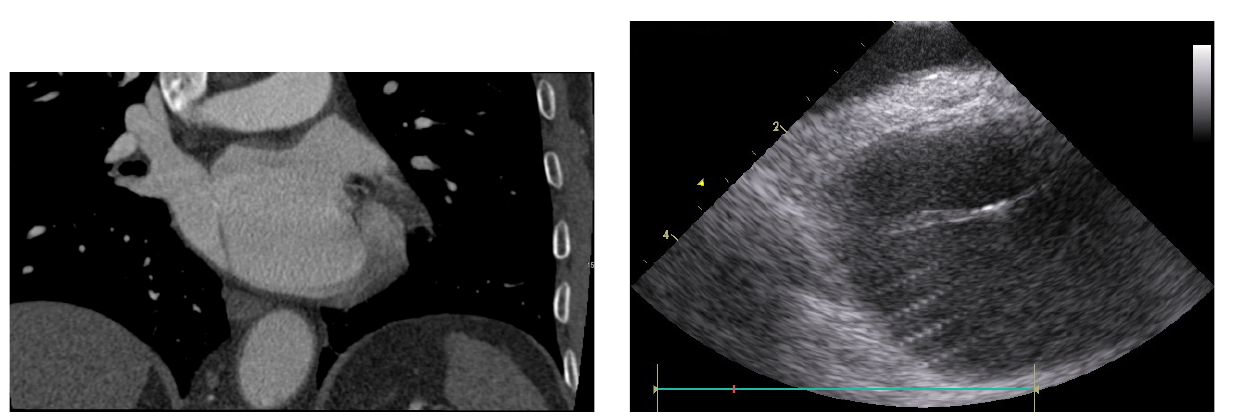
Fig. 4. Intracardiac echocardiography. A straw-like foreign body with the character of a transseptal sheath.